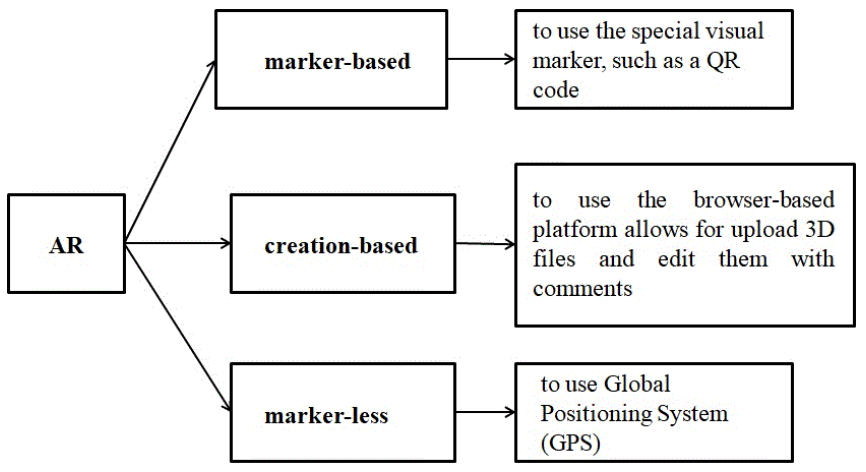
Figure 1: The three categories of mobile AR.